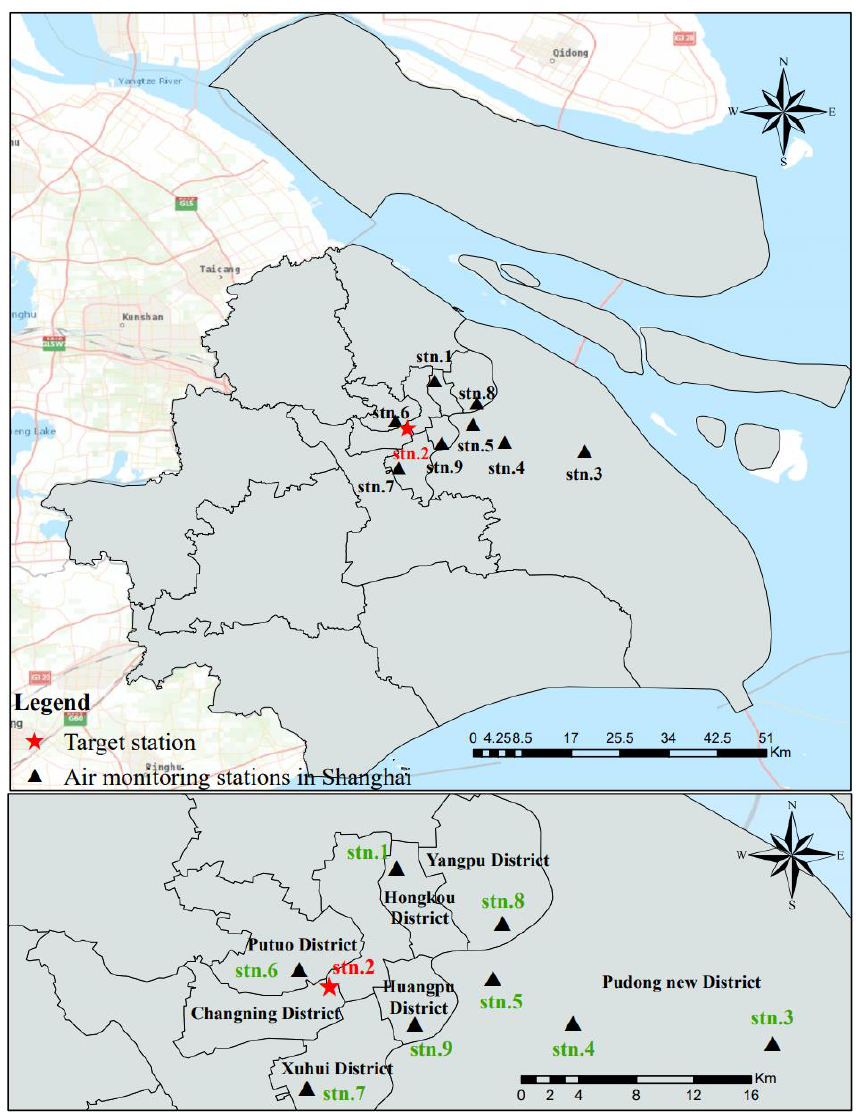
Figure 5. Study area and station distribution.